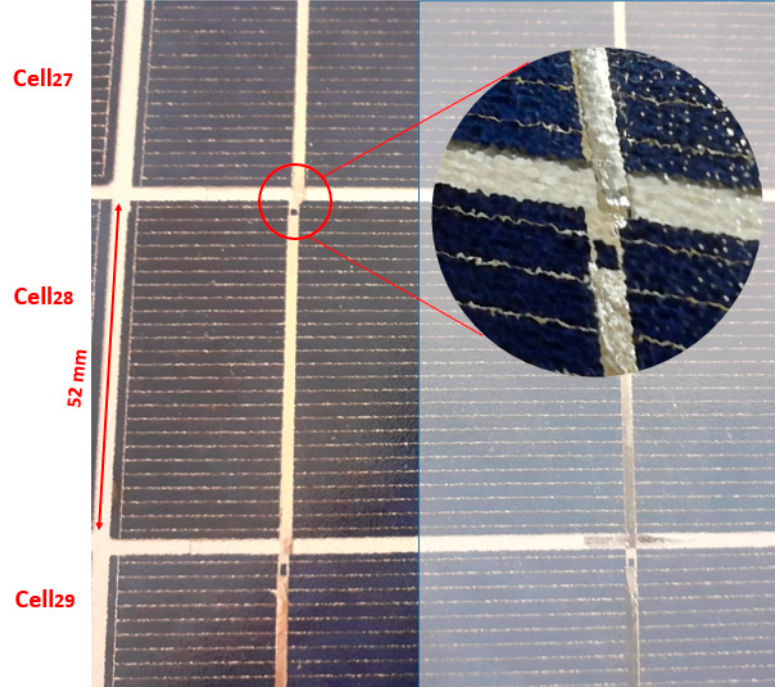
Figure 16. Bad soldering between Cell 27 and Cell 28 .